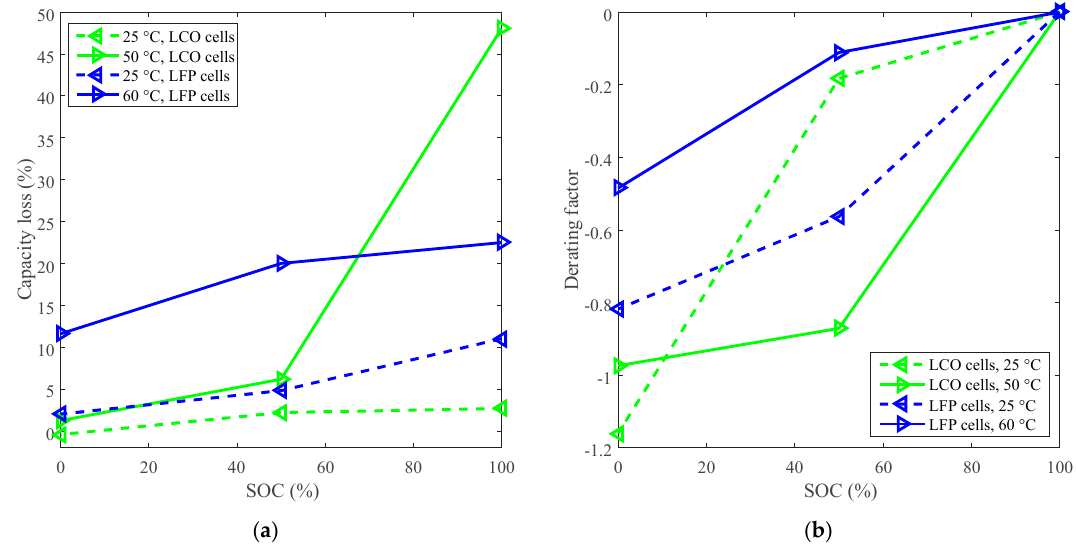
Figure 3. Derating of SOC for calendar life. ( a ) Capacity loss vs. SOC. ( b ) Derating factor vs. SOC, and the derating factors are calculated according to Equation (3).